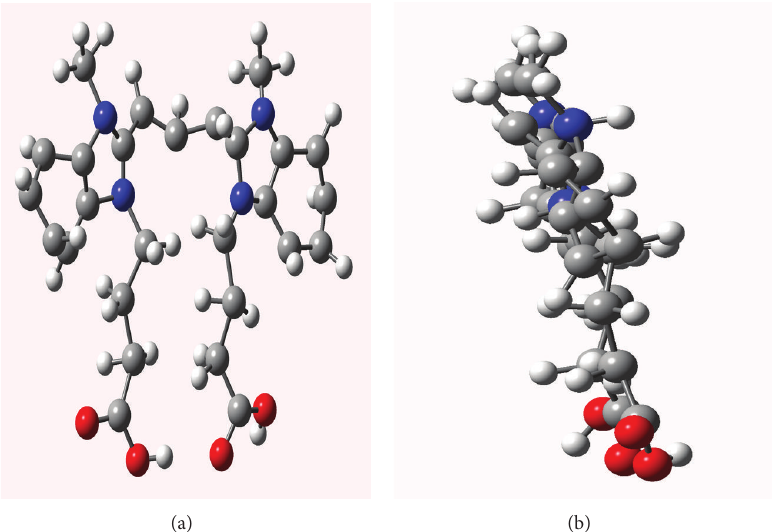
Figure 3: DFT Optimized geometry of simplified Dye 1 (Cl atoms are not taken into account and where R group = CH 3 group). (a) Front view (180 ∘ on the plane of paper) and (b) 90 ∘ twisted view (perpendicular to the plane of the paper) reveal nonplanar